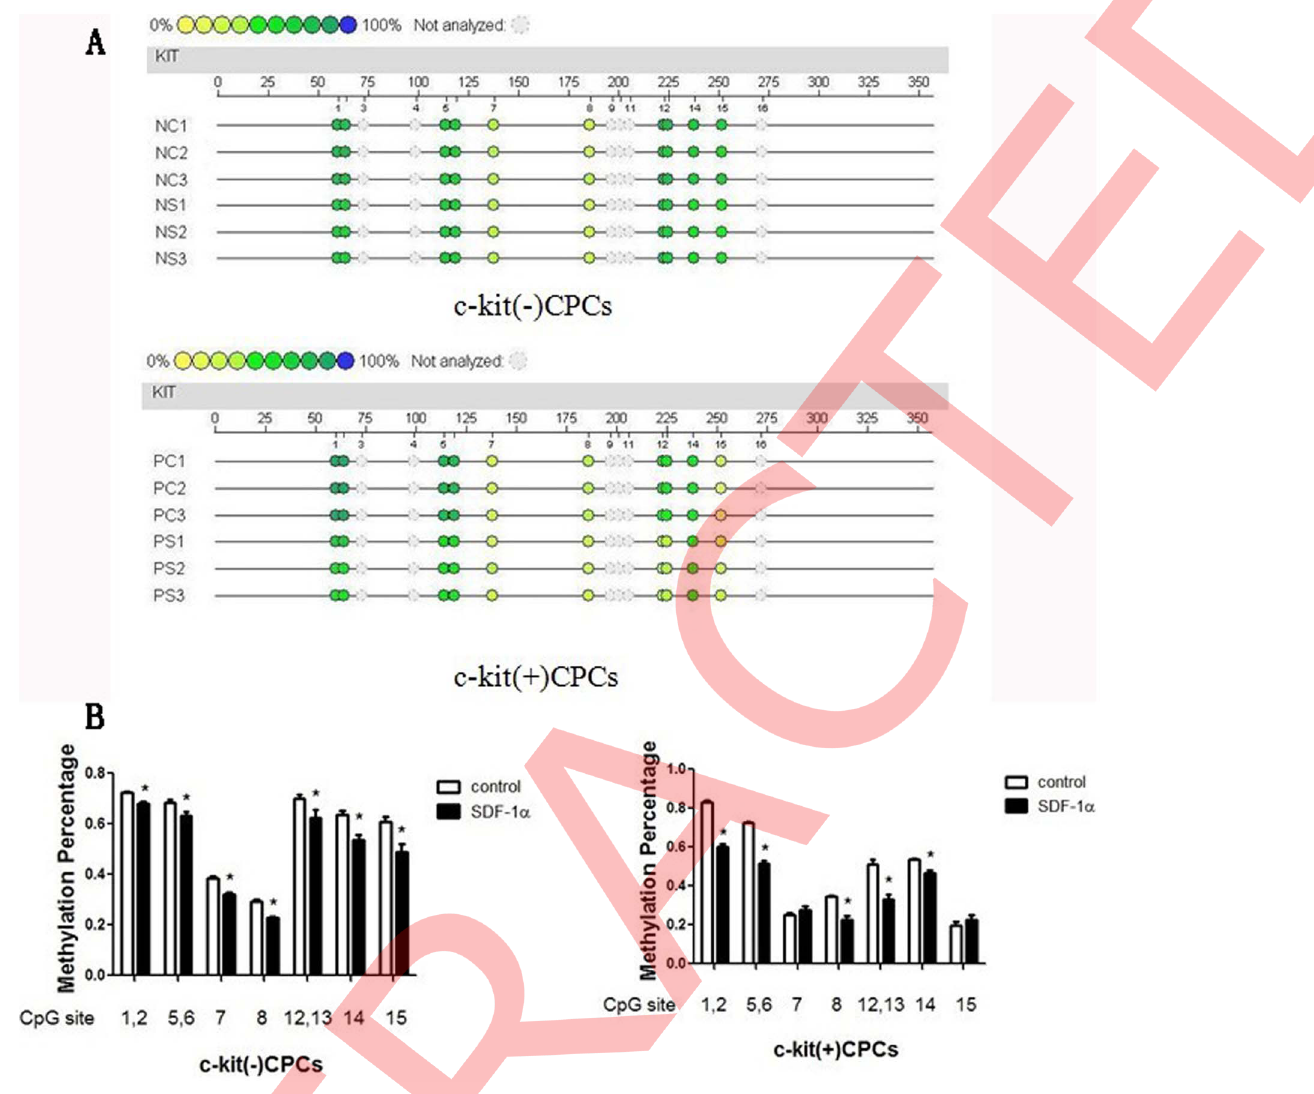
Figure 5. Induction of SDF-1 a on demethylation of the c-kit promoter in CPCs. (A) Profiling of the site-specific methylation of CpG sites in the c-kit promoter region. Each line represents a CpG methylation profile of the c-kit promoter region from the control (PC1 to PC3) and the SDF-1 (PS1 to PS3) samples. The colors of each circle represent the methylation level of each corresponding CpG unit. The white circles represent the missing data at a given CpG site. (B) CPCs were stimulated with 100 ng/ml SDF-1 a for 48 h. Genomic DNA was extracted and subjected to Bisulfite sequencing analysis. The data represent the percentage of methylation at corresponding CpG sites, with CpG site number corresponding to the sites identified in the schematic diagram. Data were obtained from three independent experiments and are expressed as mean 6 SD. n=3.rol group.n of cit and GAPHD.0.Western blot wa c-kit at both protein and mRNA level * P , 0.05 versus the control group.